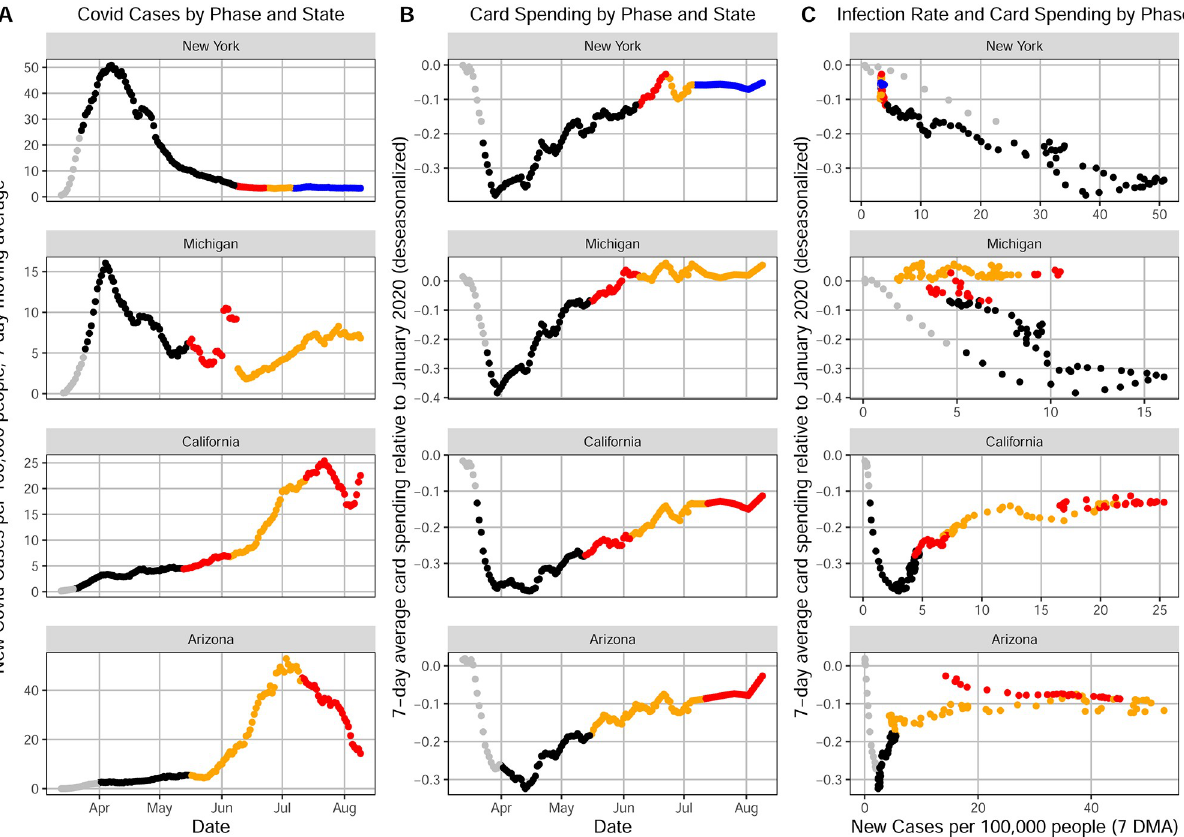
Fig 1. Temporal patterns between March 13 and August 9, 2020 for New York, Michigan, California and Arizona of (A) seven-day moving average of new confirmed daily COVID-19 cases per 100,000 people over time. (B) seven-day moving average of de-seasonalized change in consumer card spending (relative to January 2020) over time. (C) Consumer card spending as a function of COVID-19 incidence rate. The colors represent our classification of state policies into lockdown restrictions and the three phases of the White House/CDC reopening guidelines.